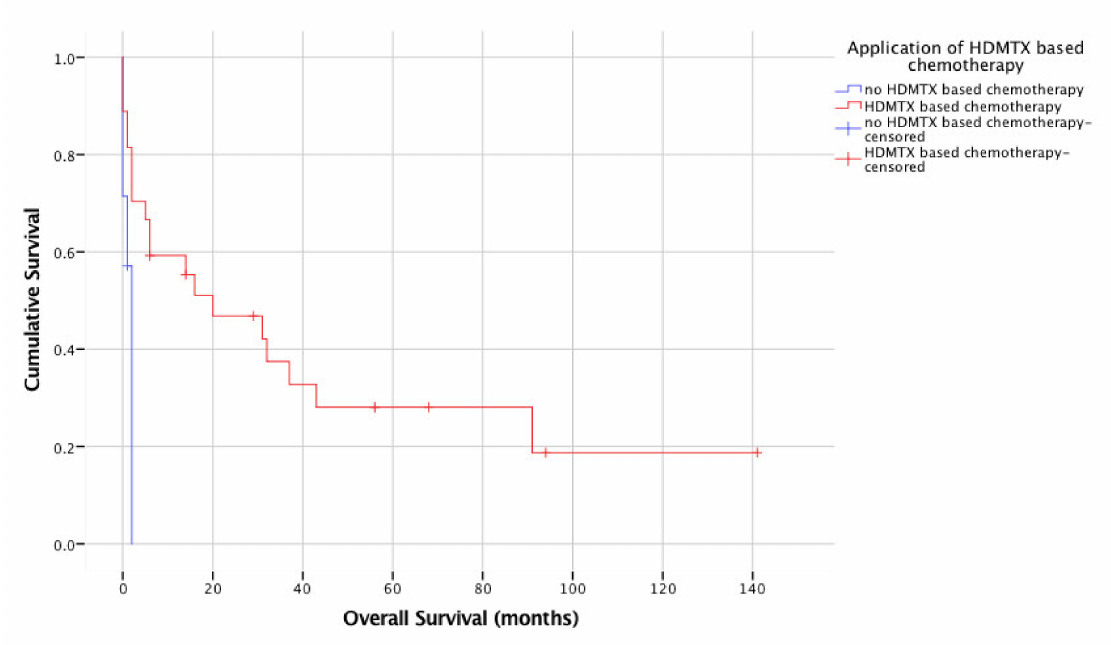
Figure 1. Overall survival according to application of high-dose methotrexate (HDMTX) ( n =